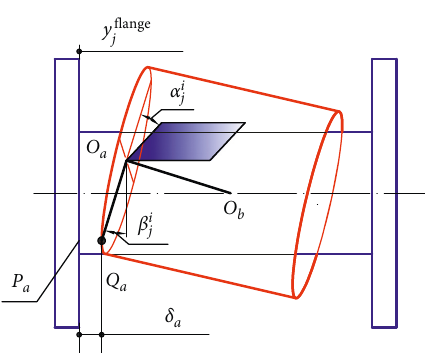
min point calculation process.